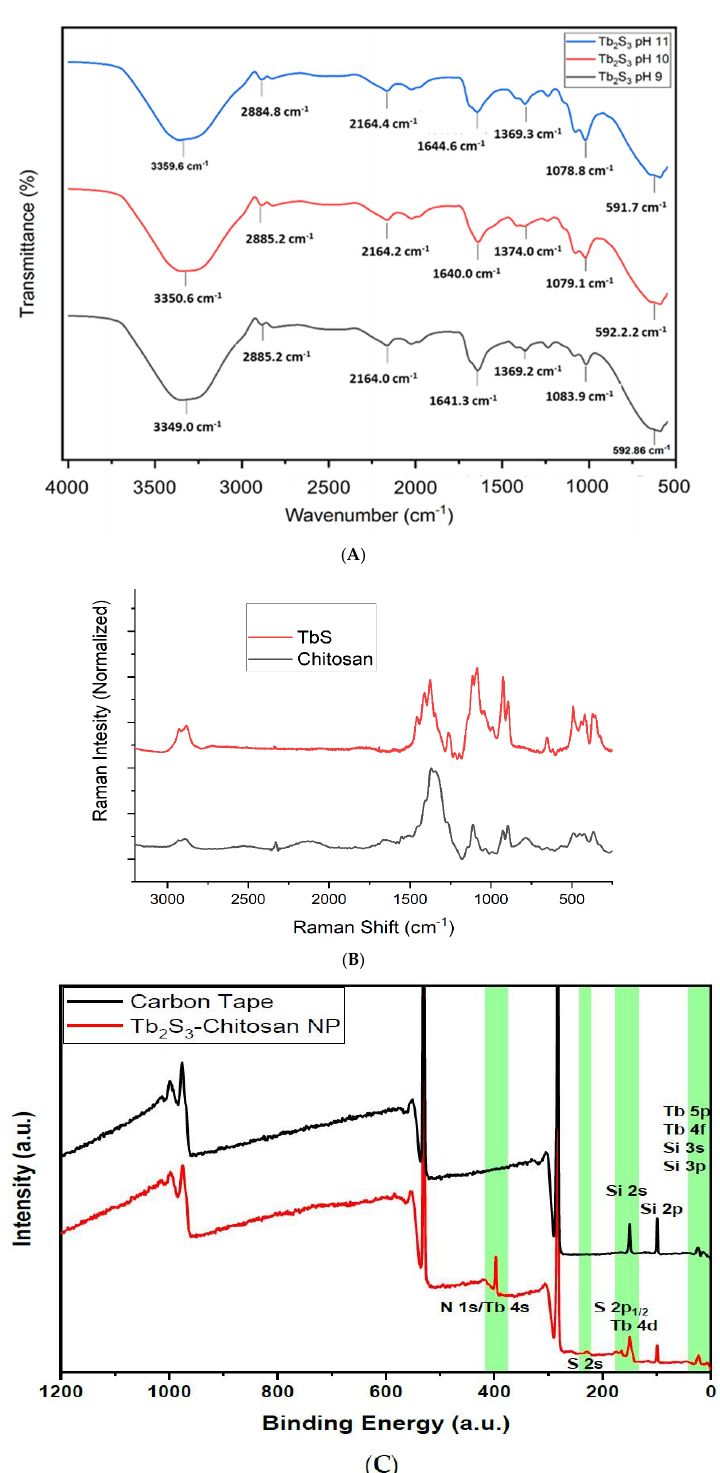
Figure 1. Spectral characterization of CS-Tb 2 S 3 NPs prepared at pH 9–11: ( A ) IR spectra, and ( B ) Raman spectrum of CS-Tb 2 S 3 NPs (pH 10), and ( C ) XPS wide scan spectrum of CS-Tb 2 S 3 NPs (pH 10) and carbon